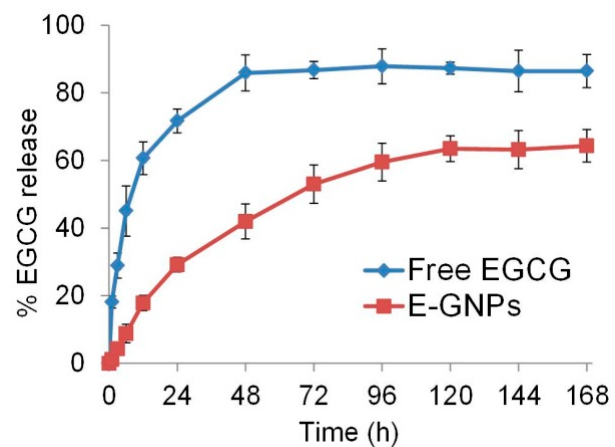
Figure 5. E-GNP nanoformulation releases EGCG in a sustained fashion. The time-dependent drug release behaviors of E-GNPs and free EGCG were quantified by spectrophotometry. The graph clearly shows sustained release of EGCG from E-GNPs nanoformulation. Data represent the mean of triplicates ± SD.